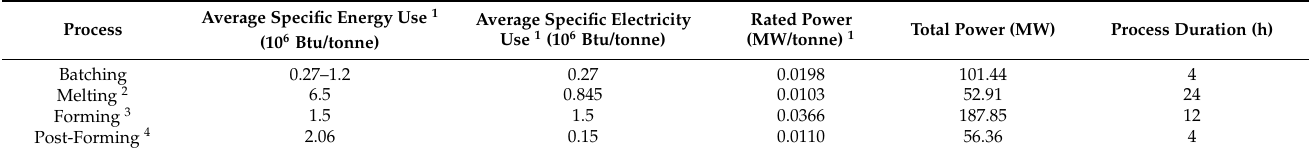
Table 11. The flat glass industry load curves in Shams Abad (full load